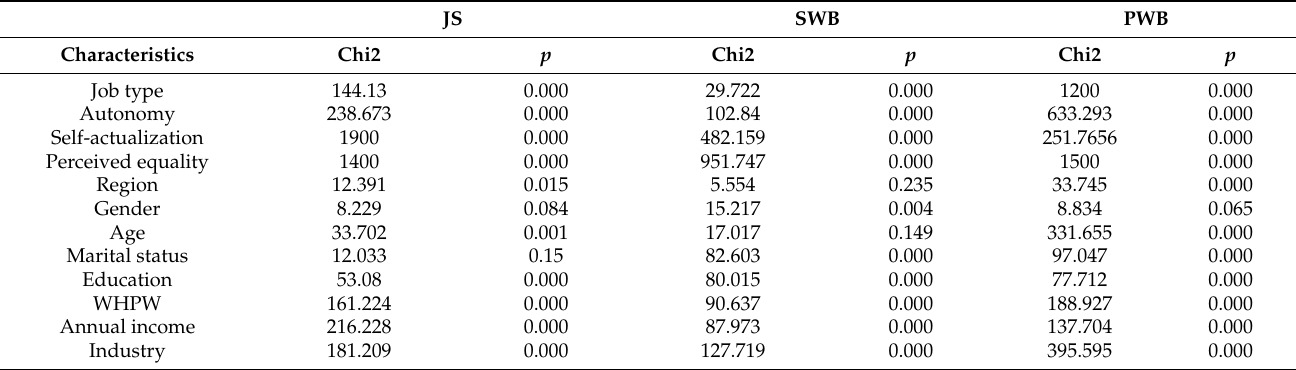
Table 3. The univariable analysis of job-related wellbeing with various factors in full sample. JS SWB